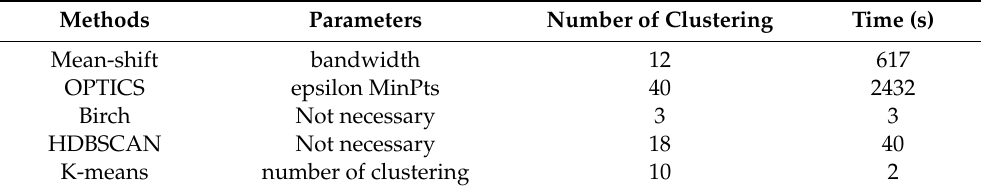
Table A1. Detailed information of each clustering methods.